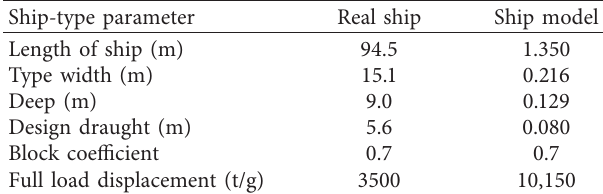
Figure 1: Ship model. Table 1: Ship-type